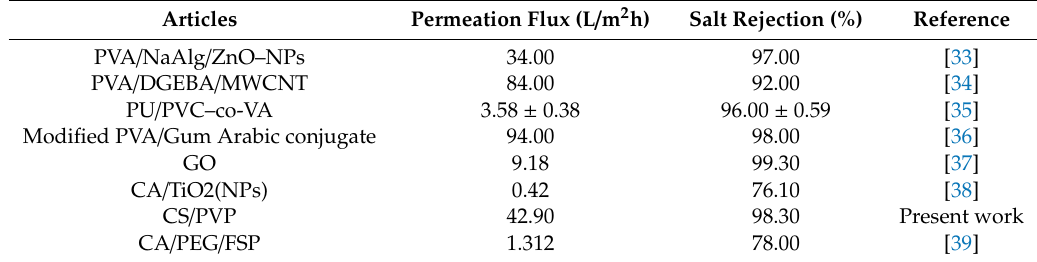
Table 1. Comparison of salt rejection and permeation flux with the state-of-the-art published work.